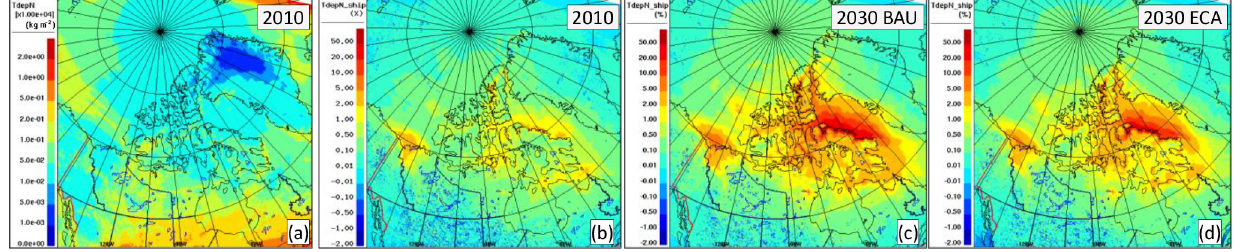
where frac i , A i , and depo i are gridded land-cover fraction (for a given land-cover type), grid area, and deposition flux, respectively, at grid cell i